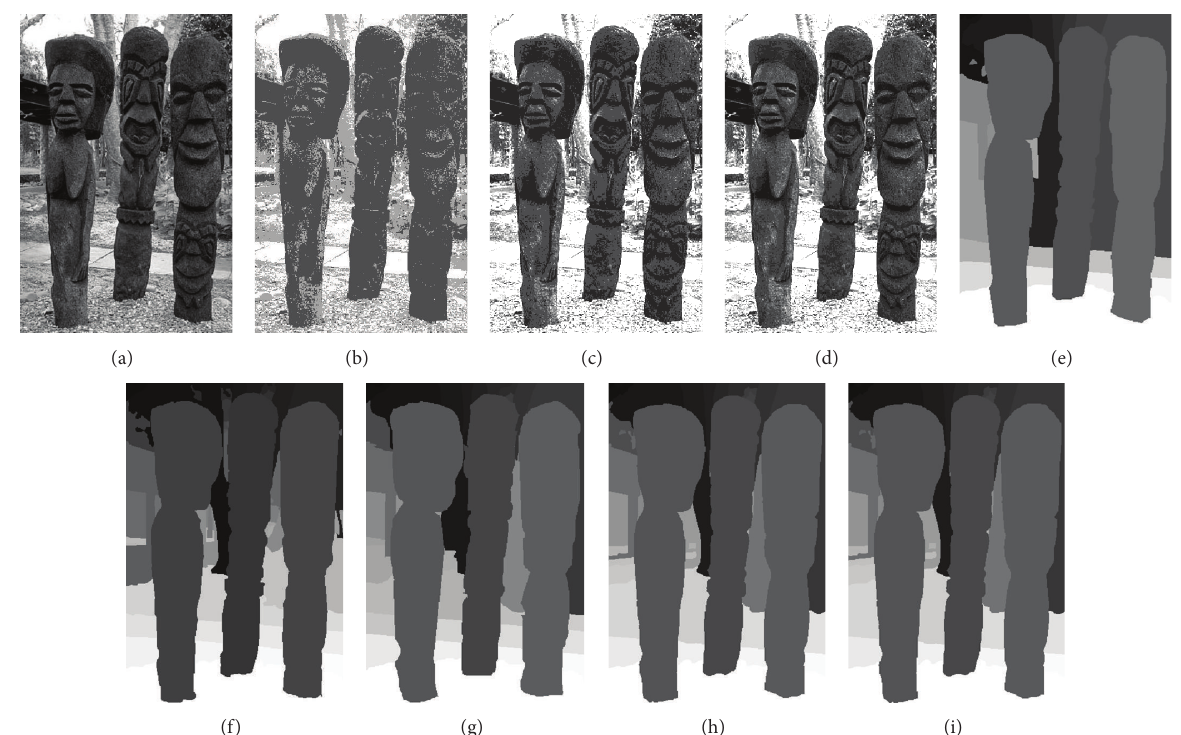
Figure 12: (a) Original image 101085, (b) M − 1 = 2 PRI = 0.63896 , (c) M − 1 = 5 PRI = 0.76413 , (d) M − 1 = 9 PRI = 0.80922 , (e)–(i) the ground-truth hand segmentations offered by Berkeley Segmentation Dataset.